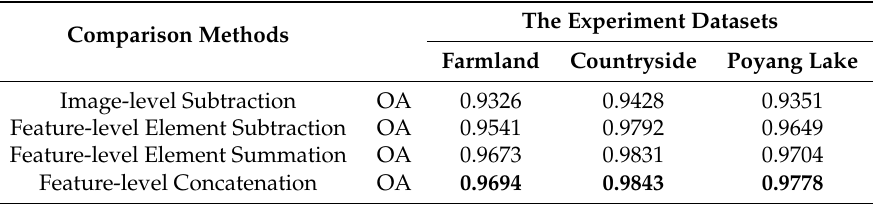
Table 3. Comparisons of different fusion strategies.